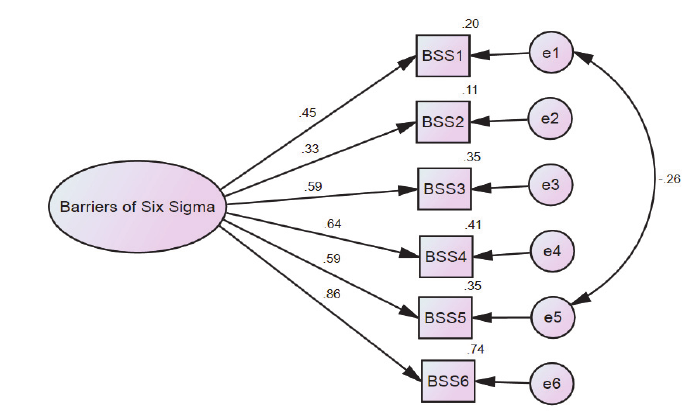
Fig. 1. Confirmatory Factor Analysis of Barriers of Six